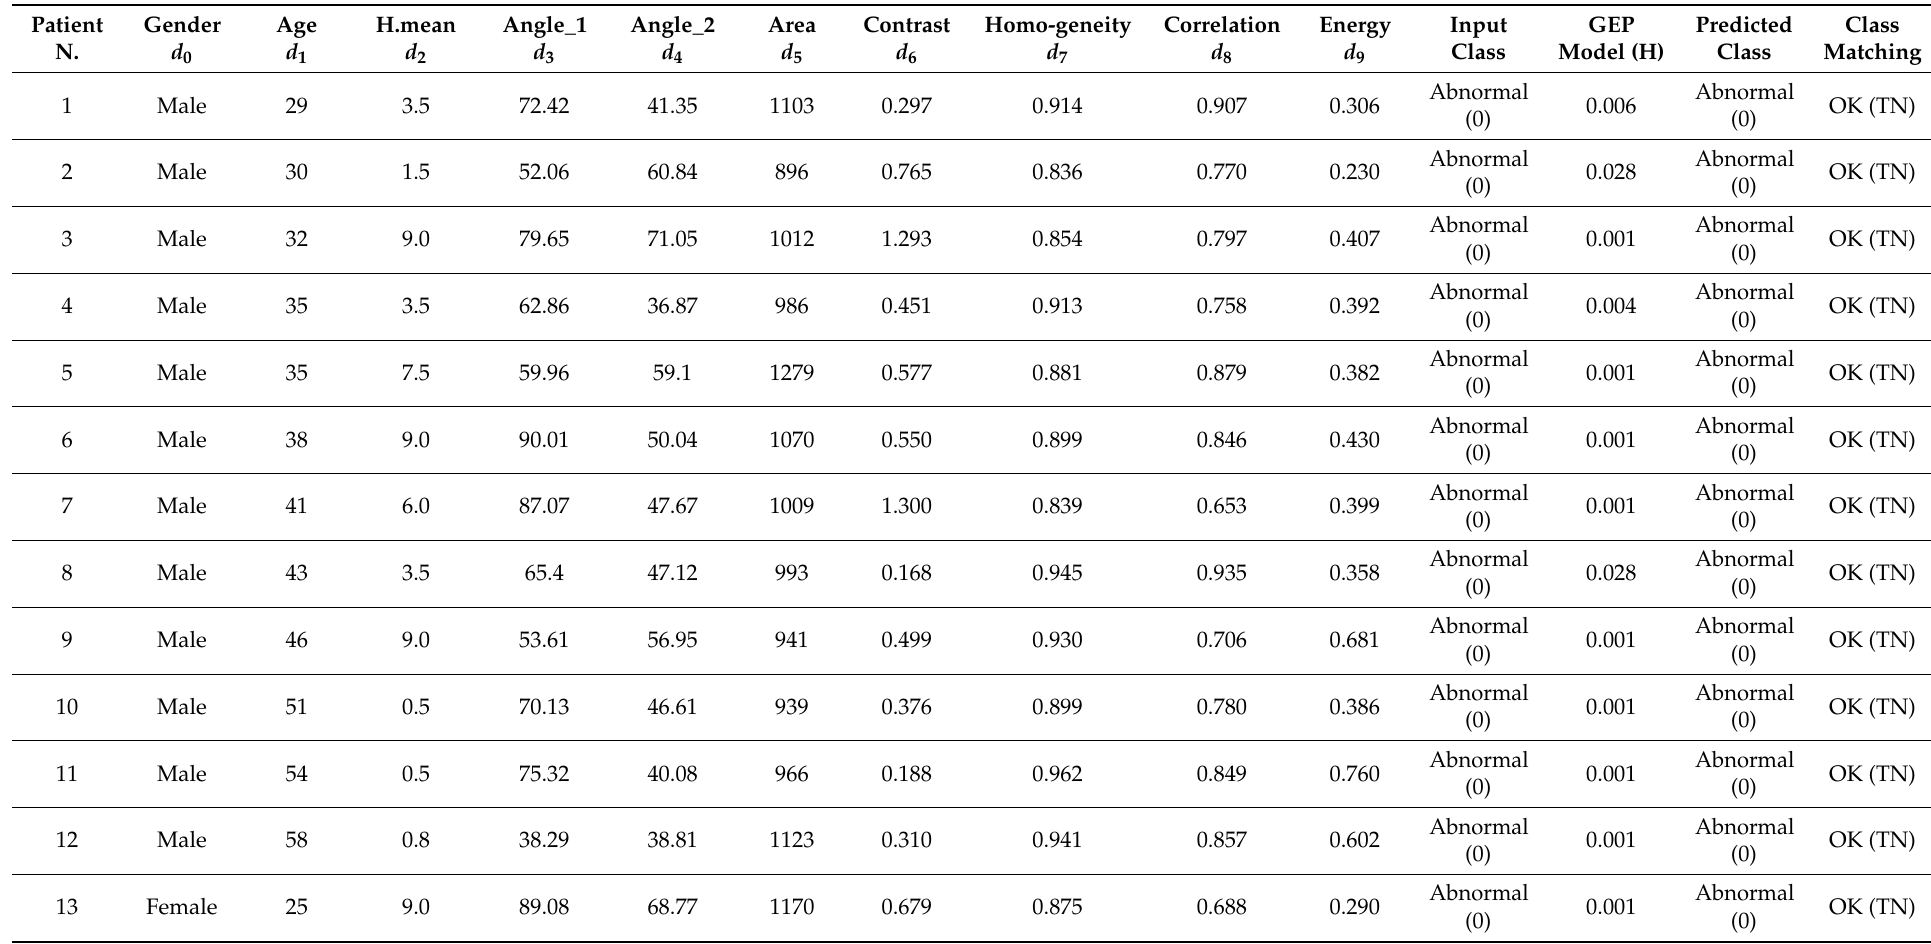
Table 10. Results of the implementation of the GEP prediction model on all 46 patients for predicting the neck-pain condition. As for the predicted class column, value 1 indicates the normal class (no neck pain for H value > 0.5), value 0 the abnormal class (perceived pain for H value < 0.5). The meanings of the parameters di (i = 0, 1, . . . , 8) are reported in Section 2.8 (Table 6), related to the mathematical GEP model developed for the neck-pain prediction. The indications given in the column “Class Matching” refer to the definitions provided in the Section 3.2 (on page